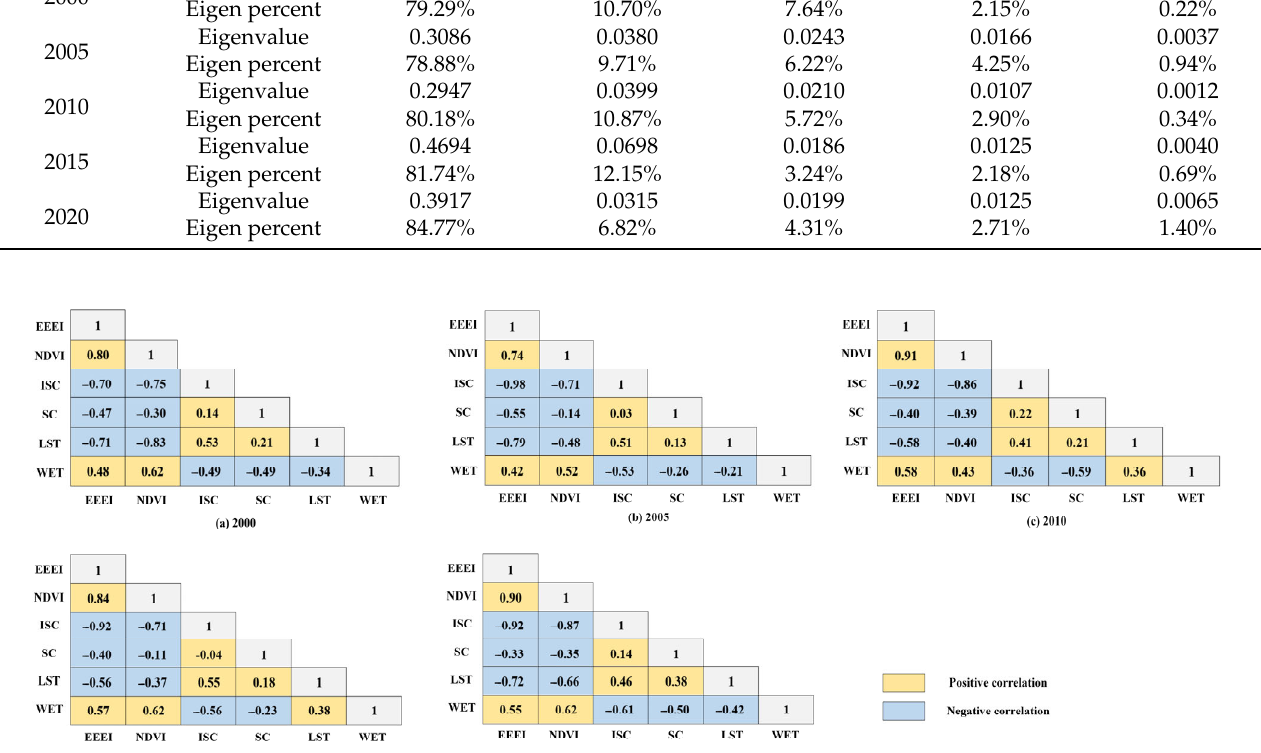
Figure 4. Correlations among the EEEI and five parameters.